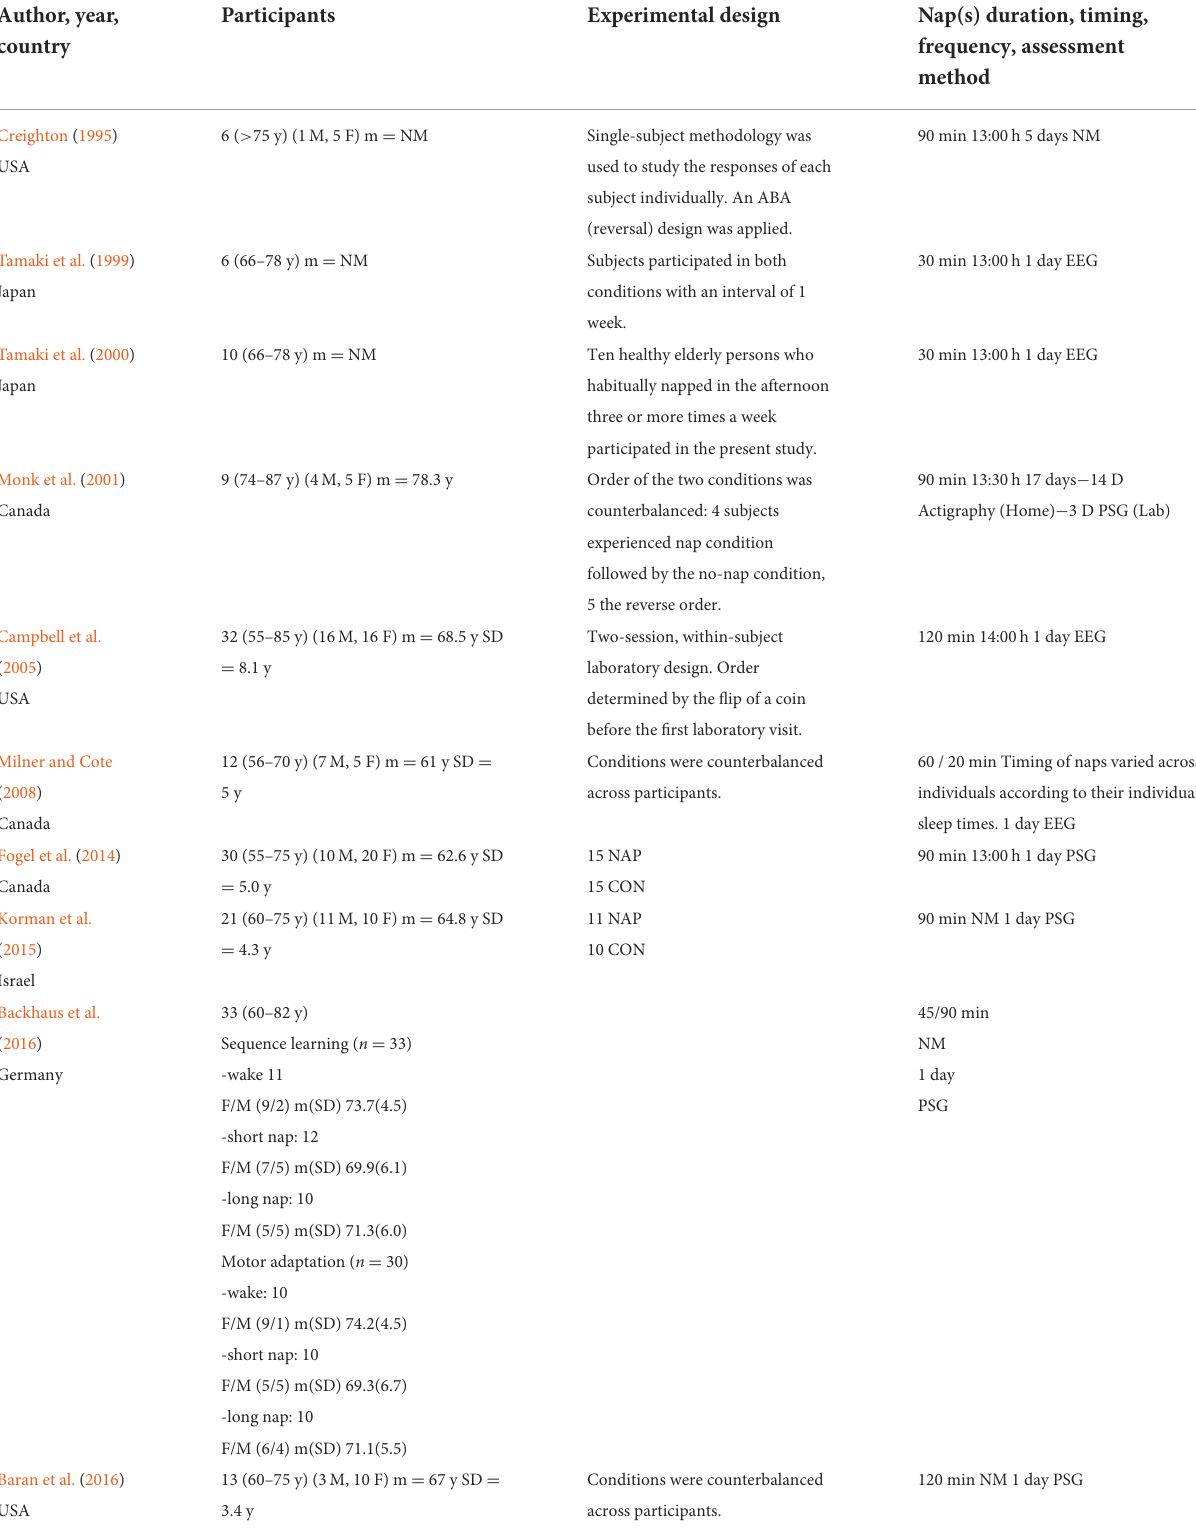
TABLE 3 Studies characteristics (population, study design and napping